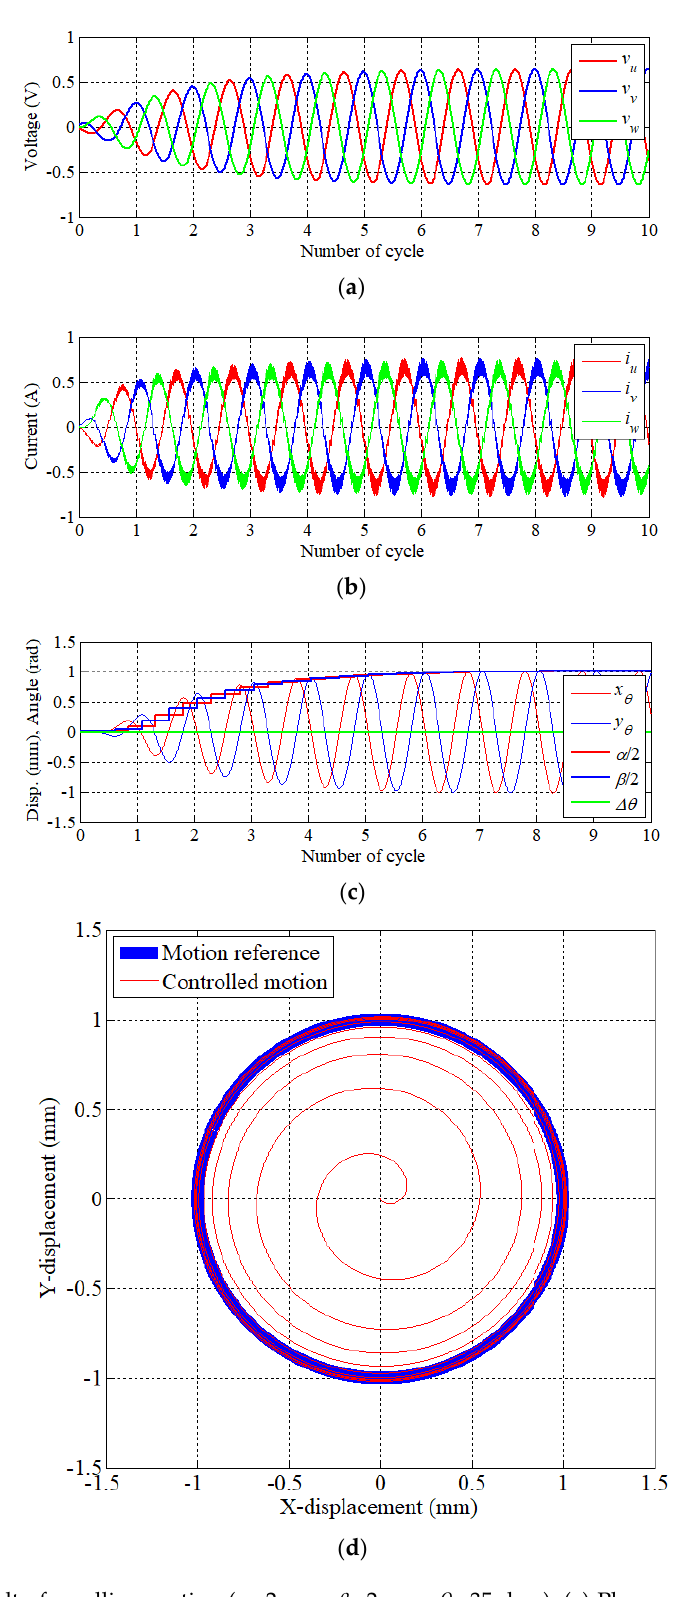
Figure 16. Result of scrolling motion ( α : 2 mm, β : 2 mm, θ : 35 deg.) ( a ) Phase voltage reference, ( b ) phase current, ( c ) displacement, and ( d ) trajectory of